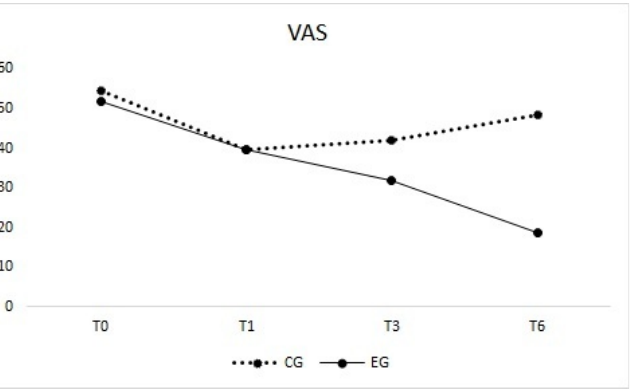
Figure 3. Median Visual Analogue Scale (VAS) scores over time in two treatment groups.